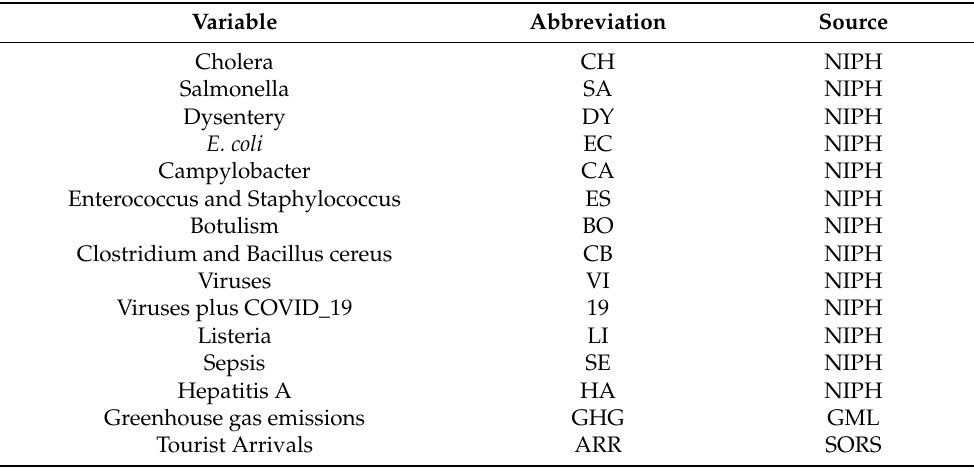
Table 2. Abbreviations for the